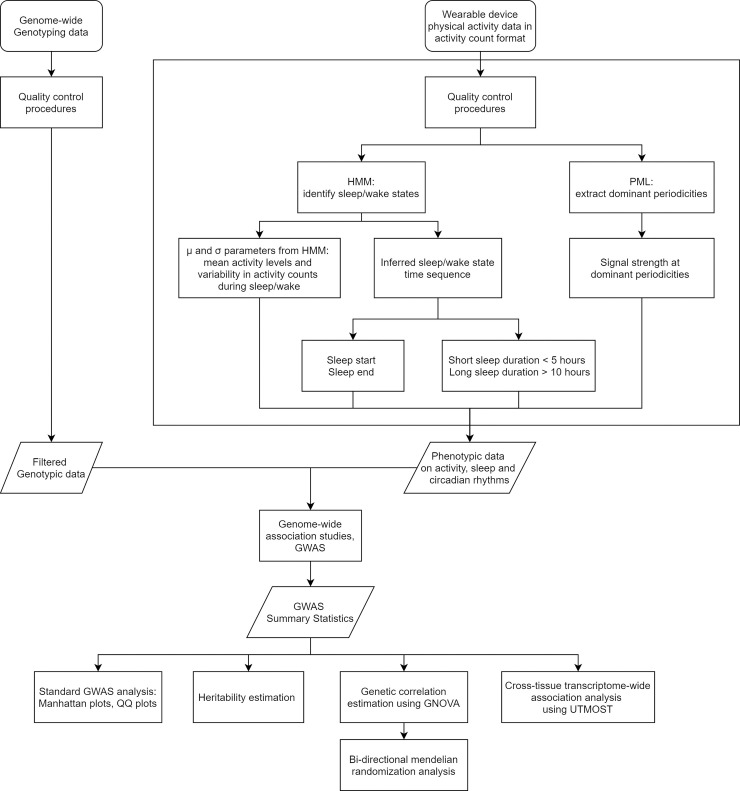
The pipeline of analyzing wearable device data and using extracted sleep and circadian features in genome-wide association studies.